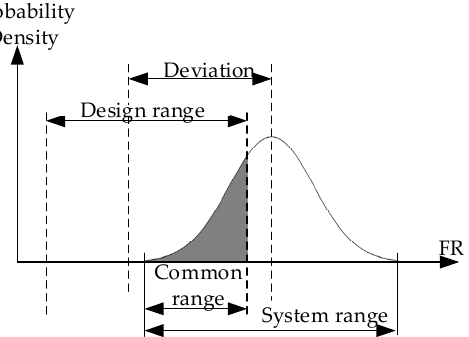
Figure 1. The probability density function of functional requirements.